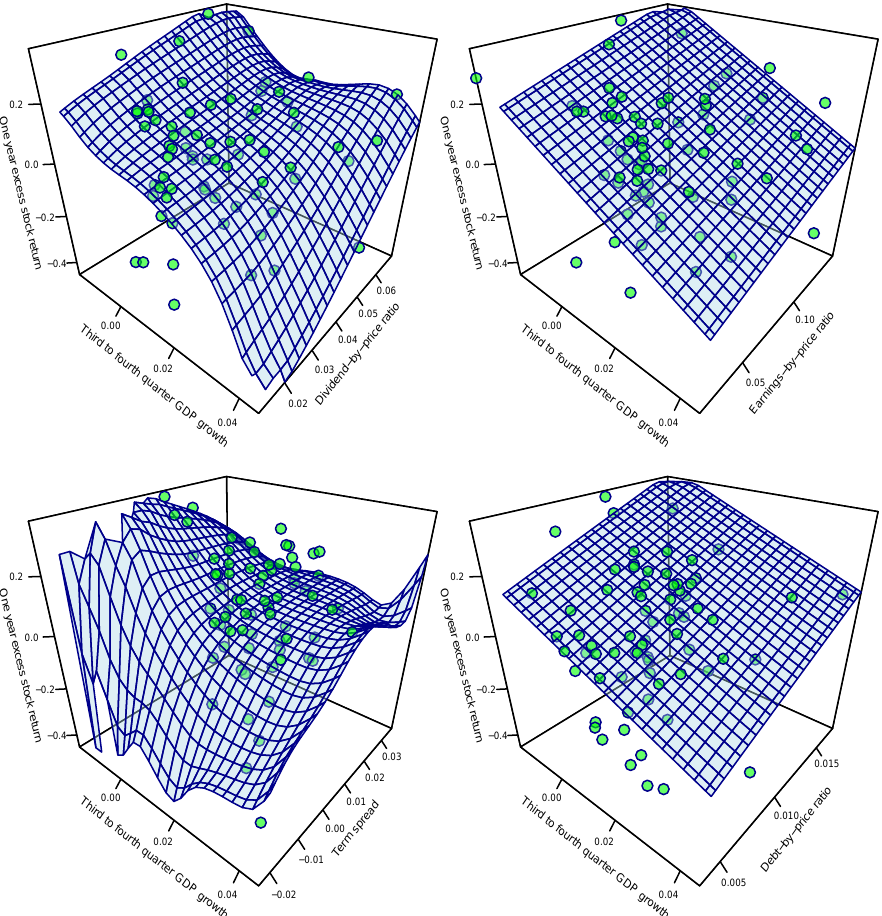
Figure 6. Risk-free rate benchmark. Relation between one year excess stock returns and the combina- tion of third to fourth quarter GDP growth with the dividend-by-price ratio, earnings-by-price ratio, term spread and the debt-by-price ratio. Estimated nonparametric function ˆ m (light blue surface), observations (green balls). The sample period is